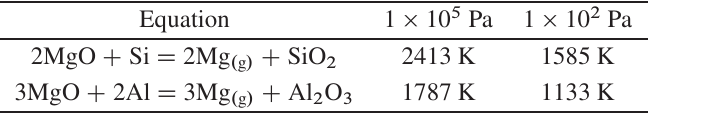
Table 3. Minimum reduction temperatures of MgO by silicothermic and aluminothermic reduction. rosion reactions. The reactions occurring in the system are shown in equations 3–7 [15].